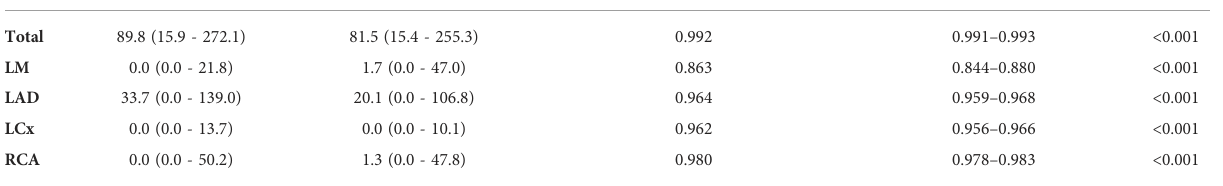
TABLE 2 Reliability for calculating the Agatston score using deep learning-based fully automated software and manual scoring on chest computed tomography. Manual scoring